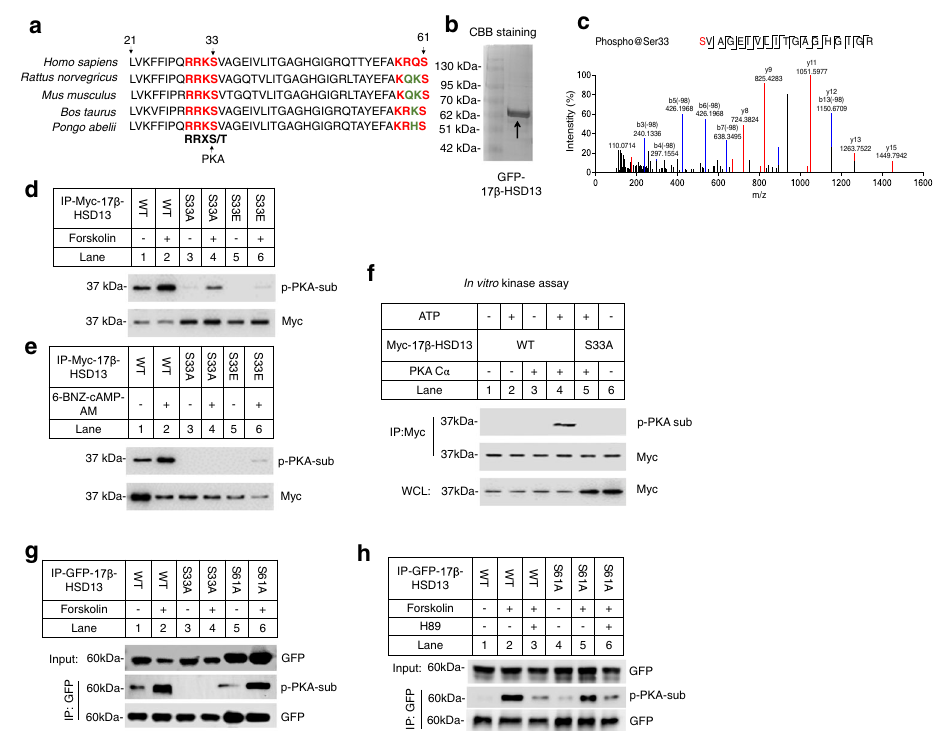
Fig. 1 | PKA phosphorylates 17 β -HSD13 at serine 33 residue. a The N terminal aminoacidsequencesof17 β -HSD13from homosapiens , rattus , mus , bostaurus and pongoabelii arealigned.Aconservedserine33residue(Ser33)whichispredictedto be a potential PKA phosphorylation site was identi fi ed among species. b HEK293 cells were transfected with a GFP-tagged 17 β -HSD13 expression vector for 24h, thentreatedwith10 μ Mforskolinfor30min,followedbyimmunoprecipitation(IP) with anti-GFP-beads. The IP product was loaded and stained with Coomassie bril- liant blue (CBB). c The major band in b was cut and digested. Phosphor-peptides were detected by LC-MS/MS. Only the serine 33 was found to be phosphorylated. Data were reproduced in three independent experiments. d , e HEK293 cells were transfected with anexpression vector carrying a full-length myc-tagged 17 β -HSD13 wild-type (WT), S33A mutant or S33E mutant, followed by IP with an